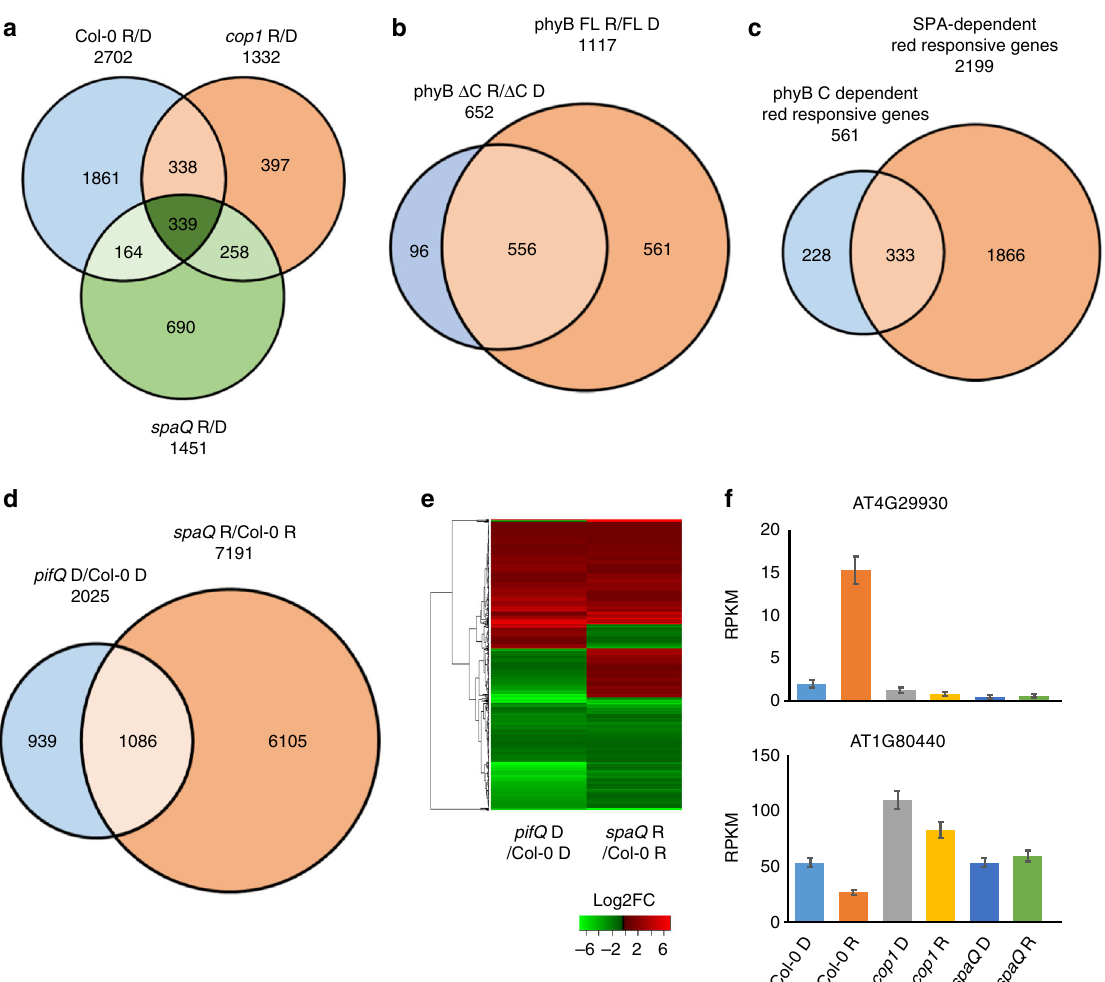
Fig. 8 RNA-sequencing revealed unique roles of SPAs in PIF-regulated gene expression. a Venn diagram of differentially expressed genes (DEGs) in a three-way comparison as indicated (Col-0 R/D, spaQ R/D and cop1-4 R/D). Genes showing differential expression in red light vs dark in three genotypes are presented. b Venn diagram of DEGs in phyB-GFP FL vs phyB-GFP Δ C in response to red light. A total of 561 genes was identi fi ed as DEGs in phyB-GFP FL that did not show differential expression in phyB-GFP Δ C. c Venn diagram showing DEGs in a pairwise comparison between SPA-dependent red light responsive genes and phyB C-terminal-dependent red light responsive genes. Sixty percent of phyB C terminal-dependent red light responsive genes are overlapped with SPA-dependent red responsive genes, supporting a role of the phyB C-terminal domain in SPA-regulated gene expression in response to red light. d Venn diagram showing DEGs in a pairwise comparison between pifQ -dependent genes in darkness and spaQ -dependent red light responsive genes. Approximately, 54% of the PIF target genes are mis-regulated in spaQ mutant. e Hierarchical clustering of 1086 DEGs in two different pairwise comparisons as indicated ( pifQ D/Col-0 D and spaQ R/Col-0 R). f Bar graph showing expression level of one light-inducible and one light-repressive gene in three genotypes as indicated. Reads Per Kilobase of transcript per Million (RPKM) values were obtained from RNAseq data. Error bar = SD, ( n = red light ( spaQ Red/ Col-0 Red) (7191 genes). PIF-mis-regulated genes (2025 genes) in darkness were previously described 60 . We found ~54% (1086/2025) of the PIF-mis-regulated genes in